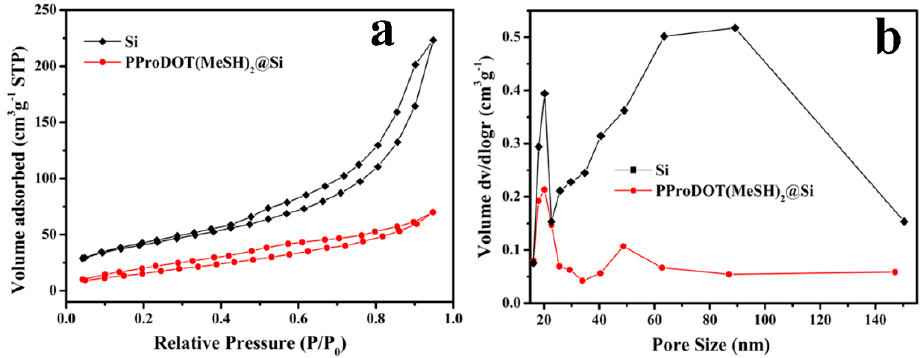
Figure 5. Nitrogen adsorption–desorption isotherms of ( a ) Si and PProDOT(MeSH) 2 @Si composite and ( b ) the corresponding pore radius distribution.